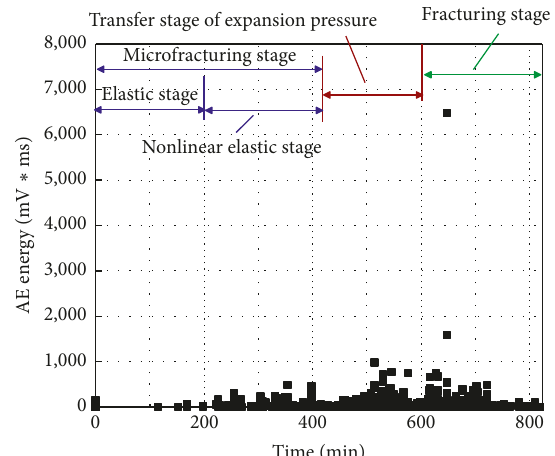
Figure 12: Scatter diagram showing the distribution of the AE energy detected during the static fracturing of the C40-C10-C40 test block.